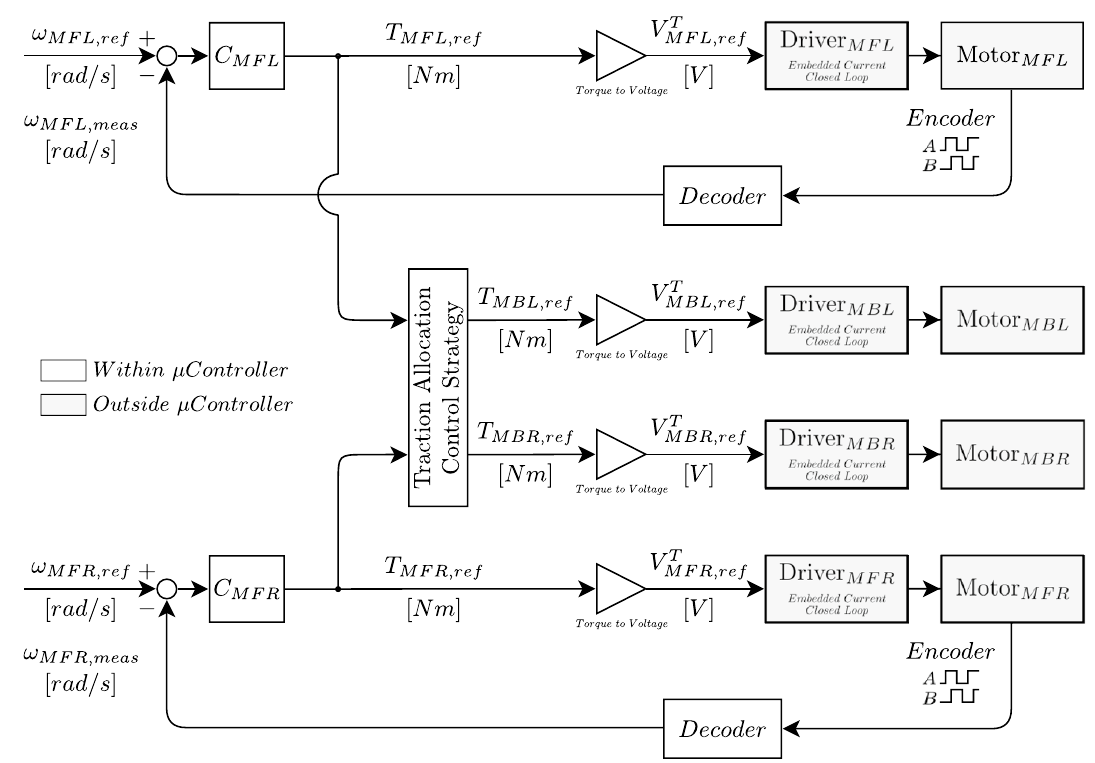
Fig. 7 Traction allocation control block